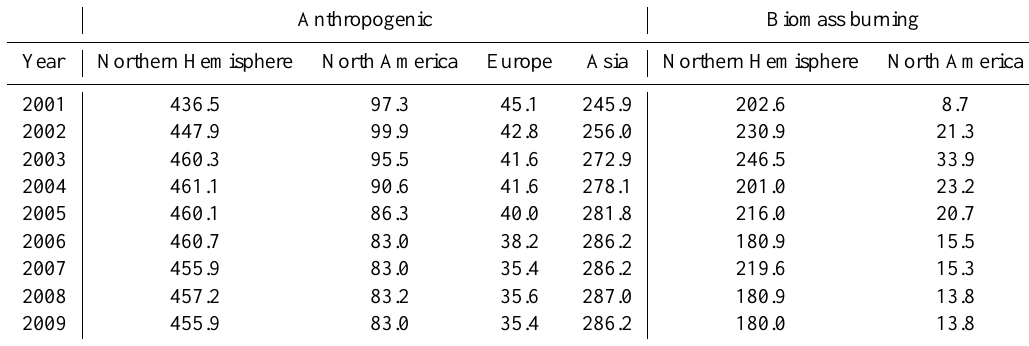
Table 1. Anthropogenic and biomass burning CO emissions used in GEOS-Chem (in TgCOyr − 1 ) Anthropogenic Biomass burning Year Northern Hemisphere North America Europe Asia Northern Hemisphere North America 2001 436.5 97.3